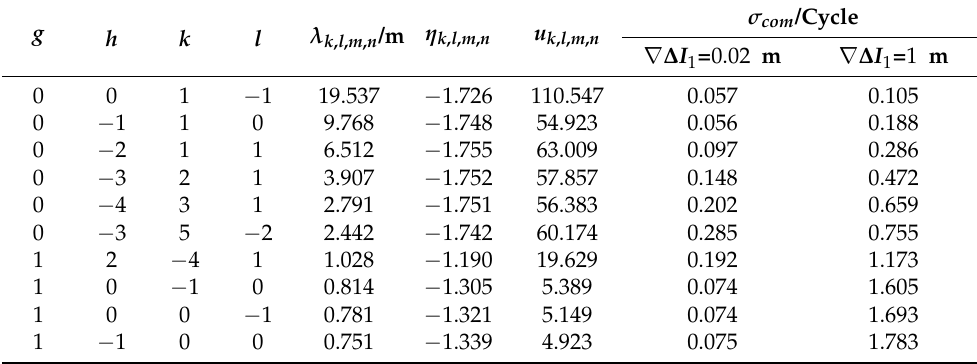
Table 1. Characteristics of typical Galileo quad-frequency combined observations.